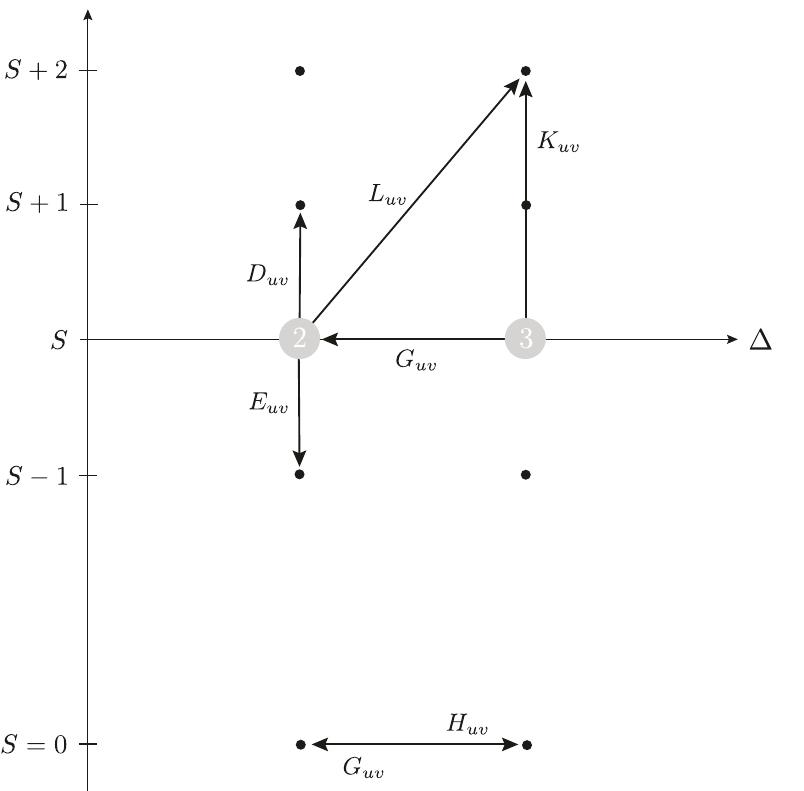
Figure 13. Illustration of the web of relations between (cid:1) = 2 and (cid:1) = 3 solutions corresponding to the exchange of particles with spin S . Only the operators D uv , G uv , L uv , and K uv maintain the number of derivatives of the solution (from the bulk point of view), while E uv and H uv increase the number of